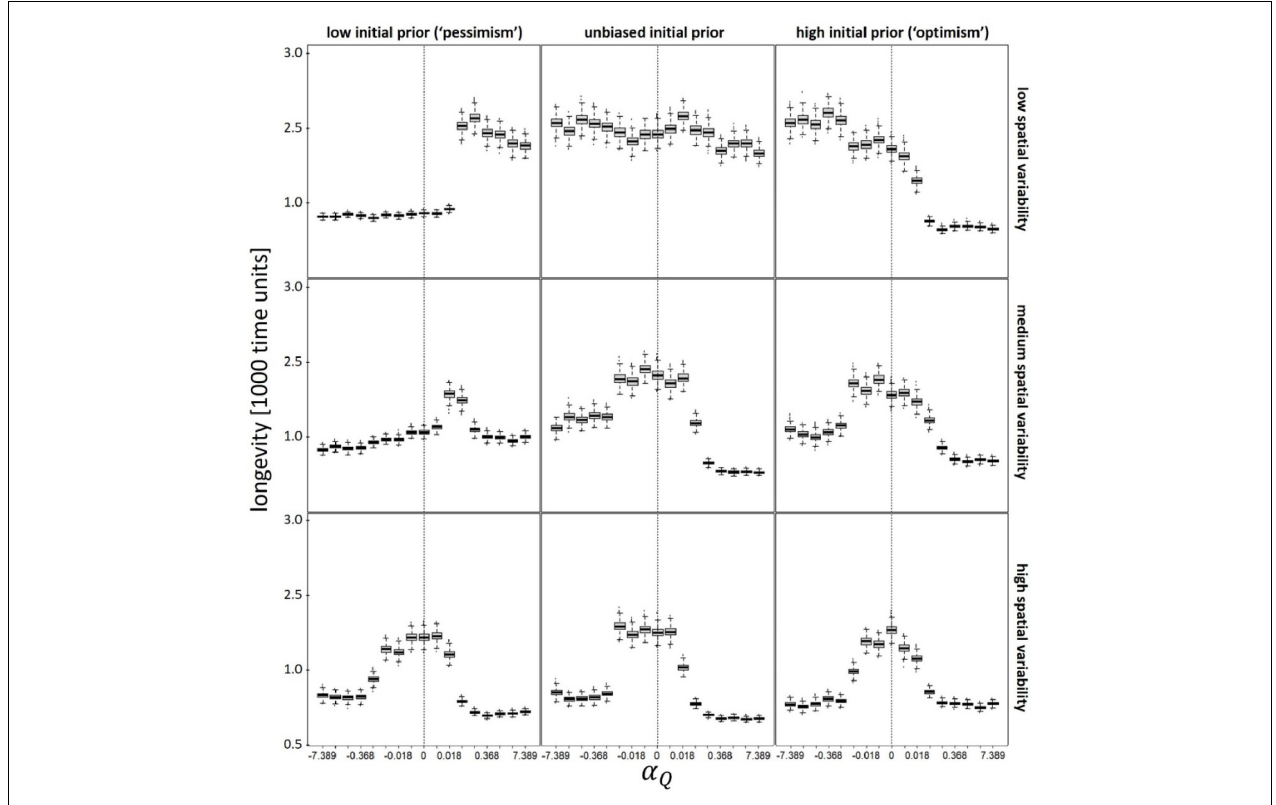
FIGURE 4 | Longevity (life expectancy) as function of valence-dependence for patch quality (positive values of α Q correspond to valence-dependent optimism whereas negative values correspond to valence-dependent pessimism). Vertical dashed lines denote unbiased learning ( α Q = 0). Different panels refer to different scenarios: low ( Q ( t = 0) = 50), unbiased ( Q ( t = 0) = 100), and high ( Q ( t = 0) = 150) initial prior belief (columns), and low ( CV ( Q ) = 0.1), medium ( CV ( Q ) = 0.5), and high ( CV ( Q ) = 1) spatial variability (rows). In each scenario, α T was kept constant at its optimal (fitness maximizing) value. T ( t = 0) = b T = 10; CV ( T ) = 0.5; P travel = t max − 1 ; other parameters and variables were as detailed in Table 1